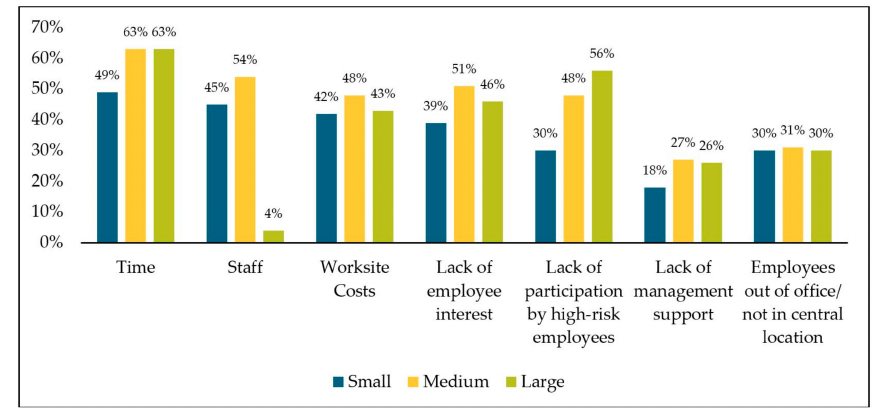
Figure 2. Weighted percentage of Nebraska worksites that indicated the following as barriers to implementing worksite health and wellness programs by worksite size,